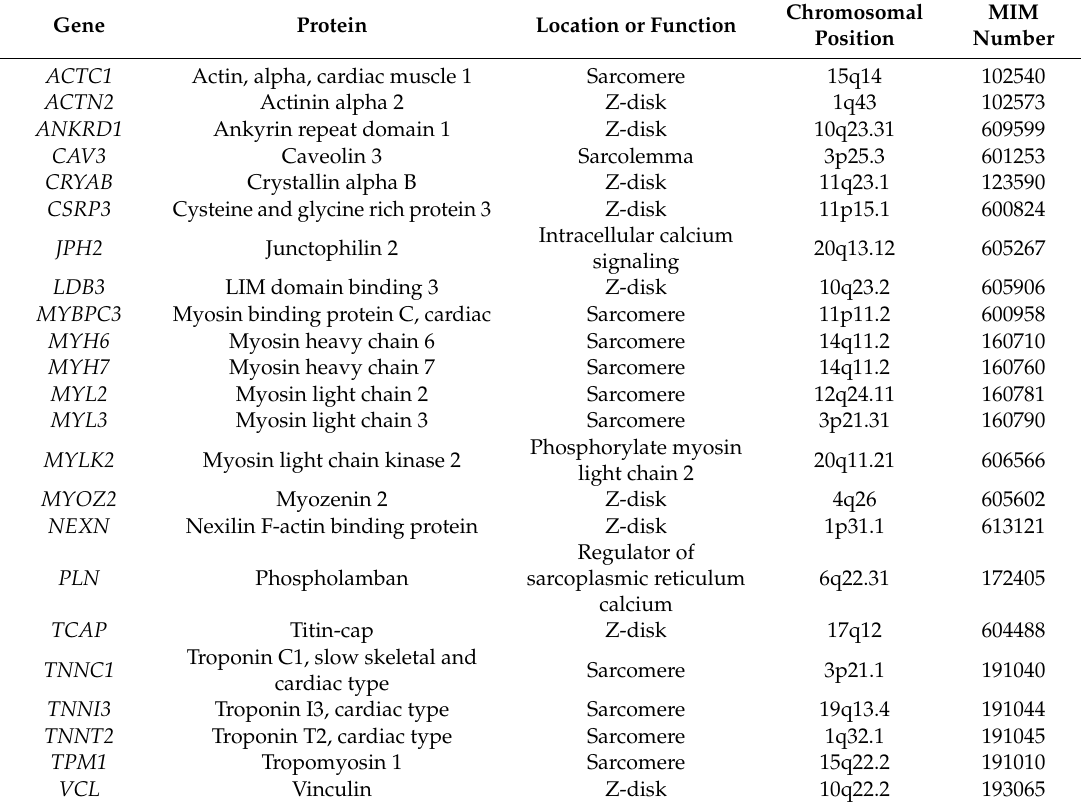
Table 1. List of genes implicated in hypertrophic